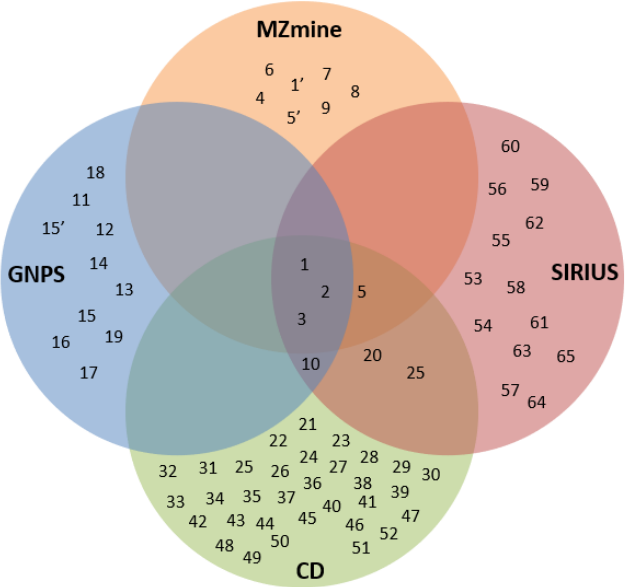
Figure 8. Venn diagram of all metabolites identified from E. indica . 1, 1’ , Loliolide;; 2, 2’ , Isoschafto- side; 3 , vitexin; 4 , 4-Ethoxy-6-methoxy-2-(8,11,14-pentadecatrienyl)-1,3-benzenediol; 5, 5’ , Adeno- sine; 6 , 5-Ethoxy-3-(10,13,16-heptadecatrienyl)-1,2,4-benzenetriol; 7 , Oryzamutaic Acid E; 8 , 1-Feru- loyl-2-hydroxyputrescine; 9 , 2-(3-Methoxycinnamoyl)-4H-3,1-benzoxazin-4-one; 10 , L-phenylala- nine; 11 , Tris(2-butoxyethyl) phosphate; 12 , Sulfamethazine; 13 , Undecaethylene glycol; 14 , 13-Keto- 9 Z ,11 E -octadecadienoic acid; 15, 15’ , N-Fructosyl isoleucine;; 16 , 9-Oxo-10 E ,12 Z -octadecadienoic acid; 17 , N-(1-Deoxy-1-fructosyl) phenylalanine; 18 , N-Lauroylsarcosine; 19 , 9,10-epoxy-12Z-octa- decenoic acid; 20 , 6-Gingerol; 21 , 13 S -hydroxy-9 Z ,11 E ,15 Z -octadecatrienoic acid; 22 , 3,5-Di- tert -bu- tyl-4-hydroxybenzaldehyde; 23 , 5-Hydroxy-2-(4-hydroxy-3-methoxyphenyl)-6-methoxy; 24 , 7-Ami- nooctadecanoic acid; 25 , 9-Oxo-10 E , 12 E -octadecadienoic acid; 26 , Alpha-linolenic acid; 27 , Benazol- P; 28 , Bis (4-ethylbenzylidene) sorbitol; 29 , Bis(methylbenzylidene) sorbitol; 30 , Citroflex A-4; 31 , Hexaconazole; 32 , Mugineic acid; 33 , N-Lauryl sarcosine; 34 , Tricin 5-o-β-D-glucoside; 35 , 2,4,8,11- Dodecatetranoic acid; 36 , Decaethylene glycol; 37 , 3,6,9,12,15,18-Hexaoxaicosane-1,20-diol; 38 , Oc- taethylene glycol; 39 , Tris(2-butxyethyl) phosphate; 40 , 3,6,9,12,15-Pentaoxapentacosan-1-ol; 41 , 3,6,9,12,15-Tetraoxadocosan-1-ol; 42 , 3-[Dodecyl(2-hydroxyethyl) amino]-1,2-propanediol; 43 , 3’- Geranyl-3,4,2’,4’-tetrahydroxy-6’-methoxydihydrochalcone; 44 , 6-(1,3-Benzodioxol-5-yl)-2-oxo-4- phenyl-1,2-dihydro-3-pyridinecarbonitrile; 45 , Dibutyl phthalate; 46 , Methyl 9,10-dihydroxystea- rate; 47 , Methyl 9H-b-carboline-3-carboxylate; 48 , Hexaethylene glycol; 49 , N,N-Bis(2-hydroxy- ethyl)dodecanamide; 50 , N-Lauryldiethanolamine; 51 , Nonaethylene glycol; 52 , Safingol; 53 , 2,6-